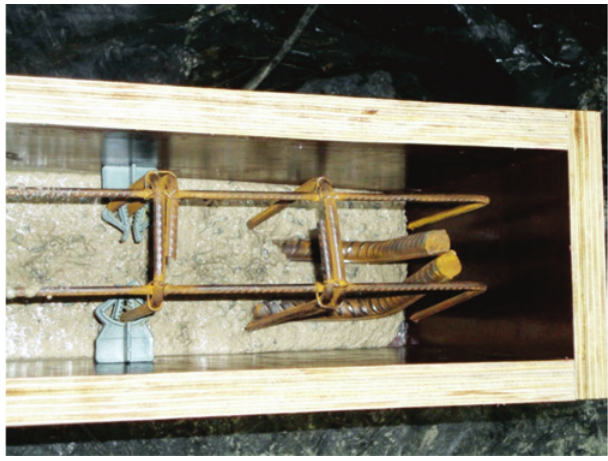
Application of Geopolymer concrete in the